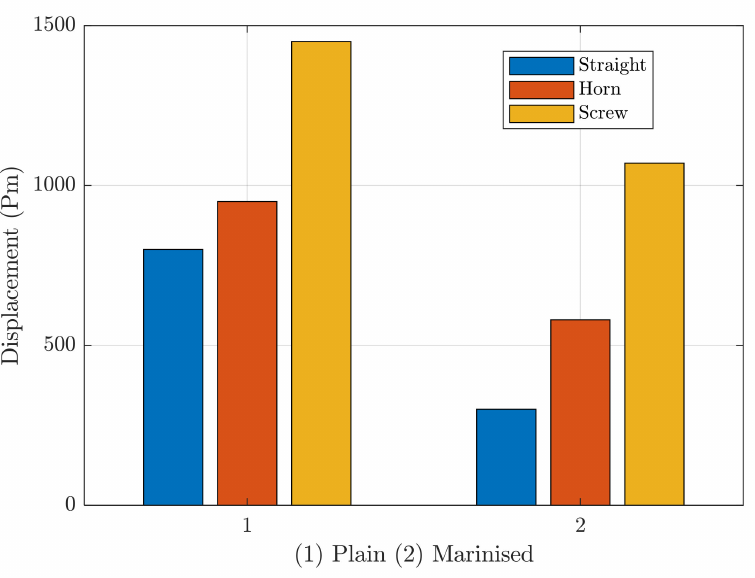
Figure 7. Maximum averaged peak-to-peak displacements for plain and marinised transducer